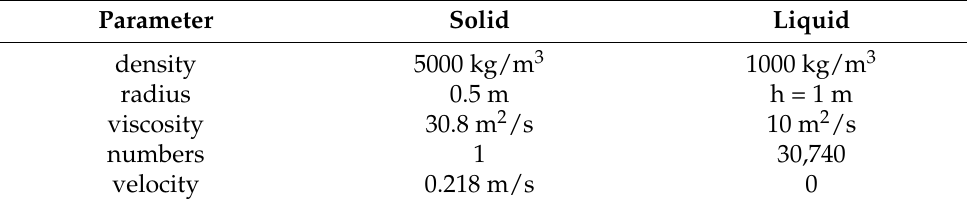
Table 1. Parameters of the DEM and SPH particles in the sedimentation case